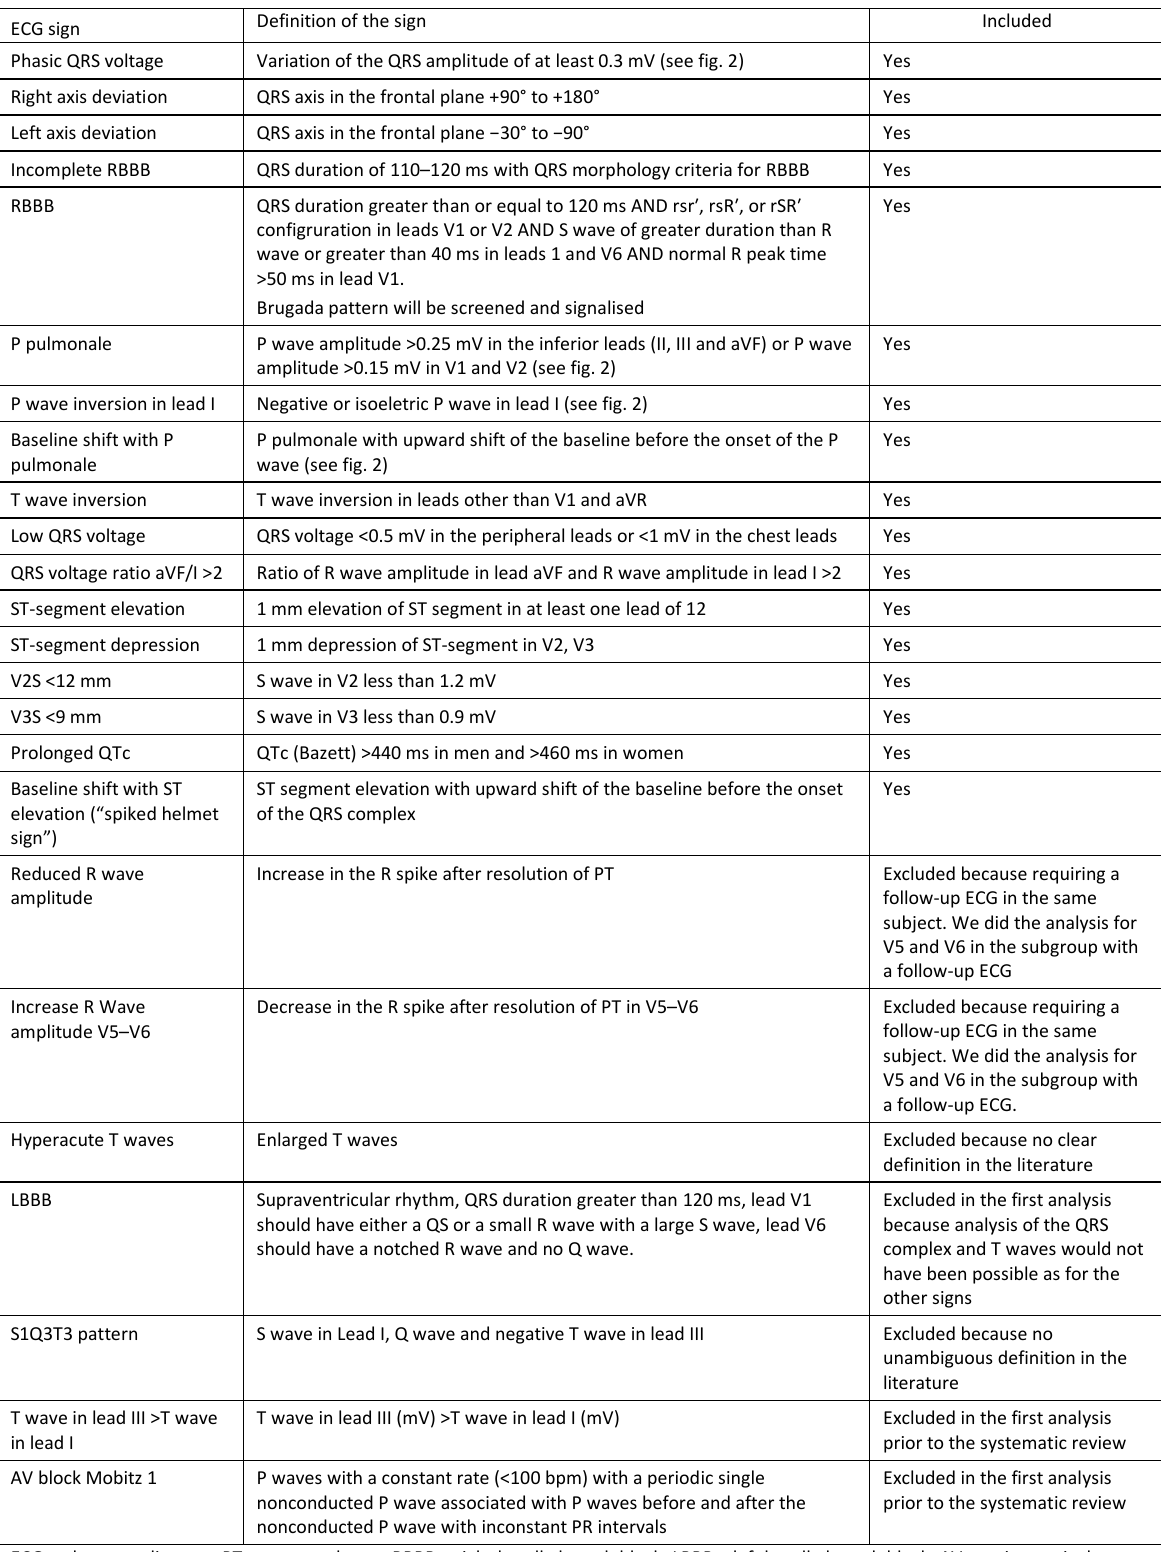
Table A2. Definition and inclusion or exclusion of the different ECG signs in the retrospective cohort. ECG sign Definition of the sign